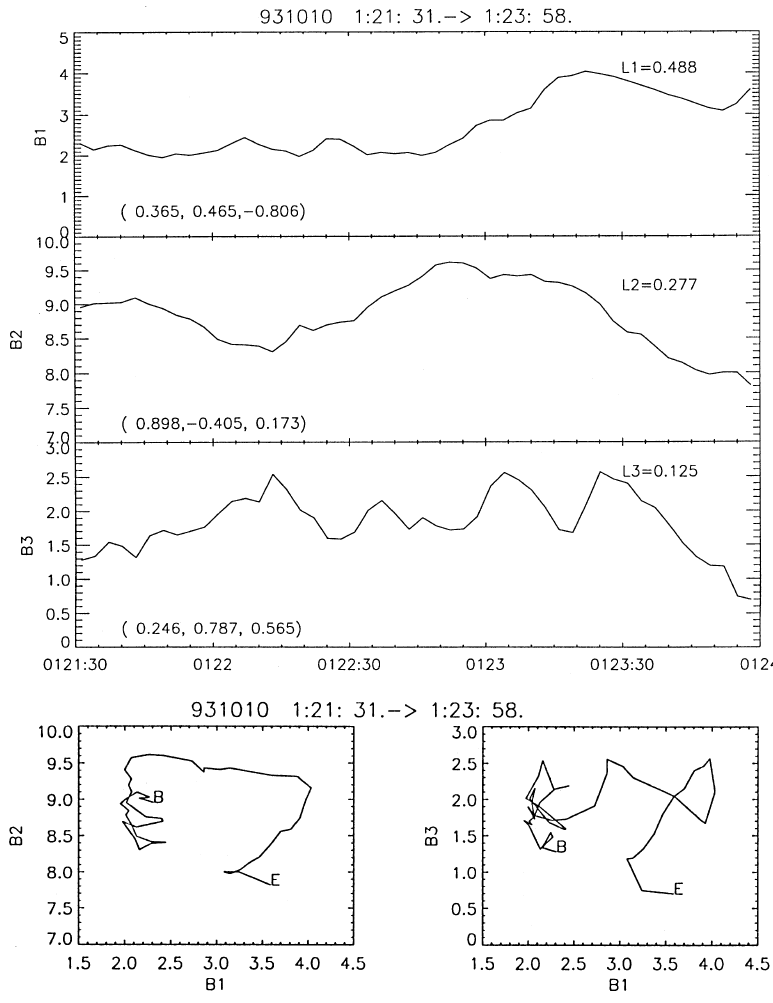
Fig. 7. 3 s averages of the GEOTAIL magnetic field data across the boundary layer plasmoid displayed in principal axis coordinates. Hodo- grams of the field variation in two orthogonal planes are shown in the bottom